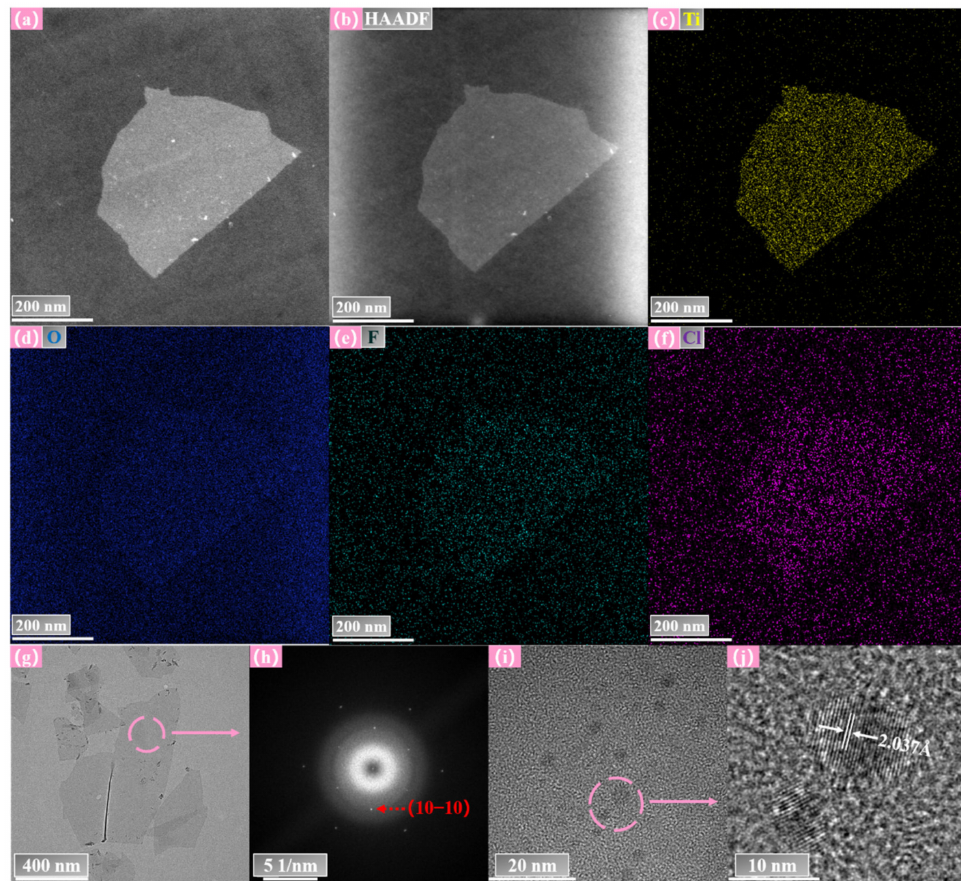
Figure 2. ( a ) TEM image of Ti 3 C 2 T x NS. ( b ) HAADF image of the Ti 3 C 2 T x NS. ( c – f ) EDS elemental mappings of Ti, O, F, and Cl, respectively, for the Ti 3 C 2 T x NS. ( g ) Ultrathin Ti 3 C 2 T x NSs with distinctive wrinkled morphology. ( h ) The SEAD diagram corresponds to the pink area in ( g ). ( i ) TEM image of Ti 3 C 2 T x QDs. ( j ) Quantum dots with distinct lattice stripes correspond to the pink region in ( i